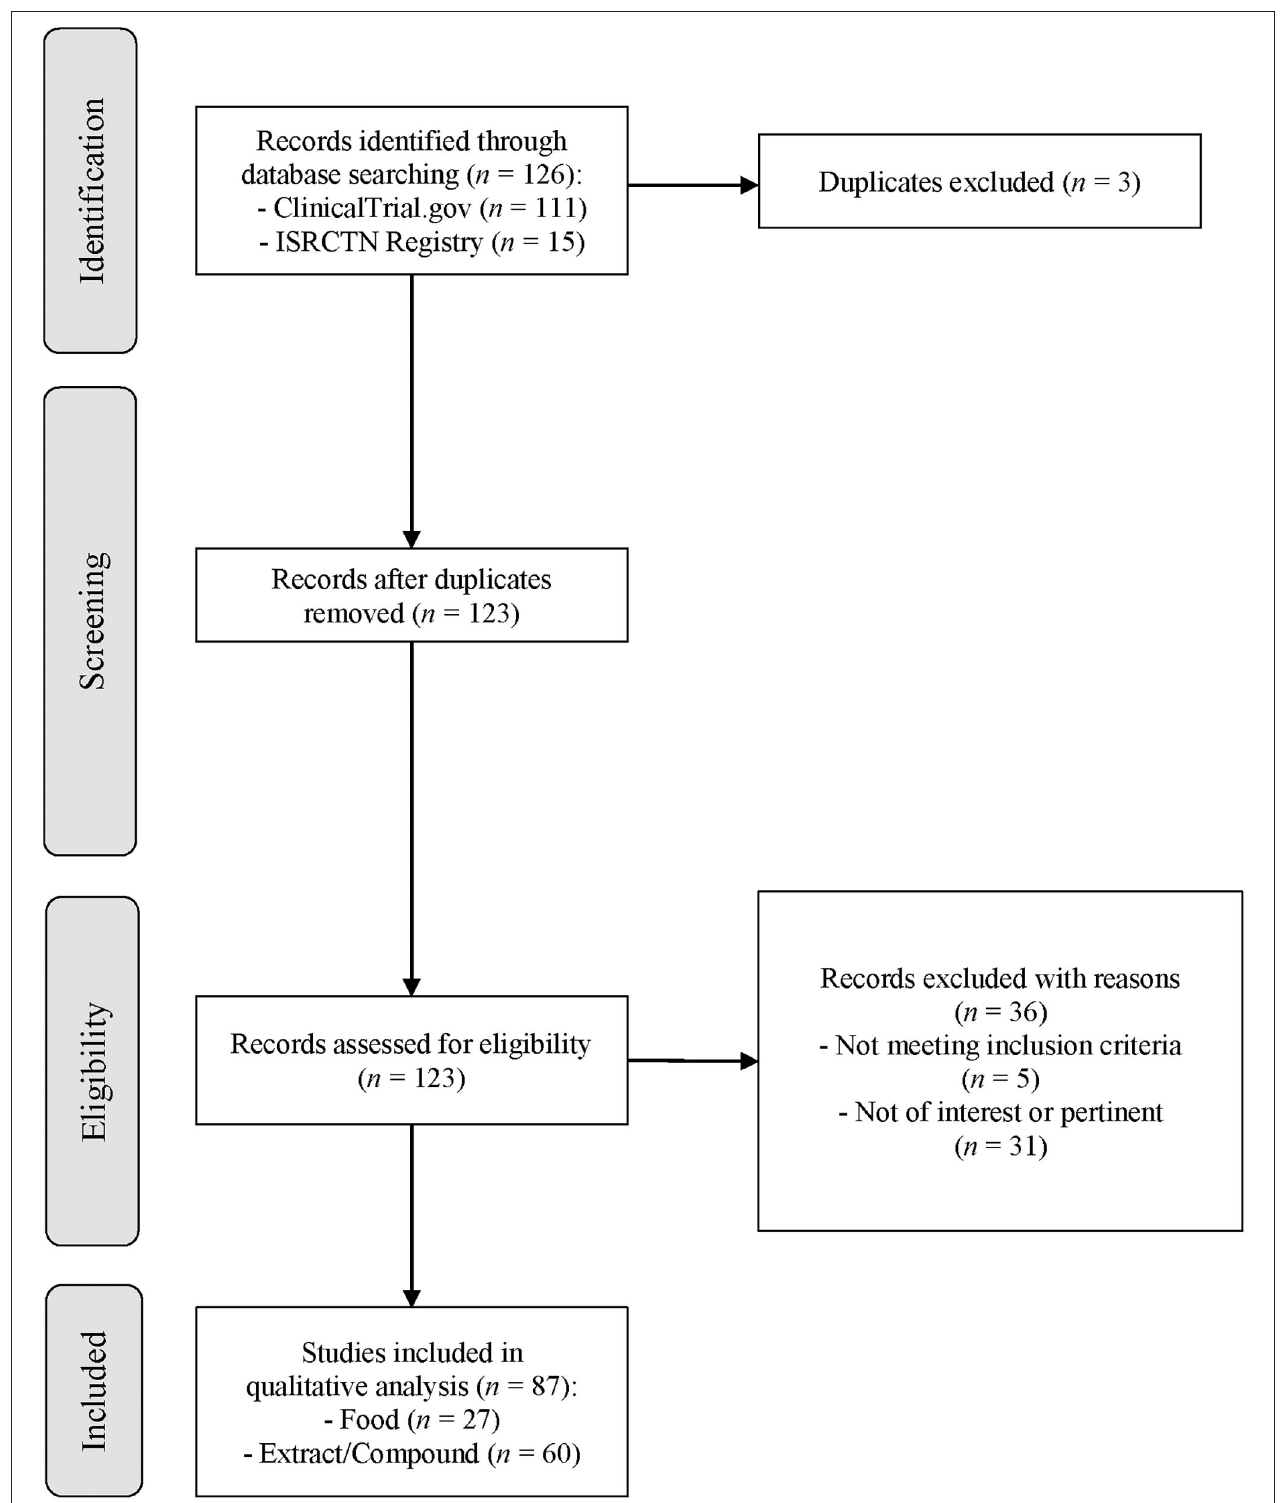
FIGURE 1 | Flow diagram of the literature search process. Legend: ISRCTN, International Standard Randomized Controlled Trial Number.